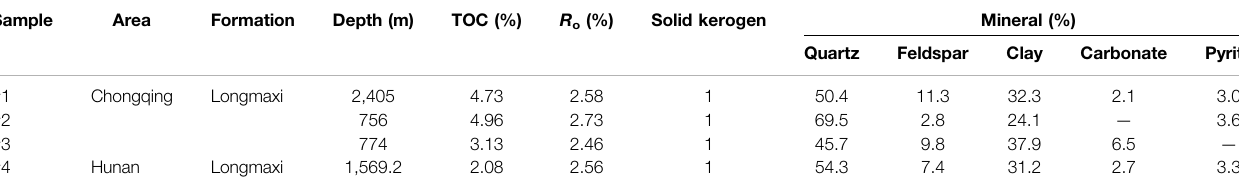
TABLE 2 | The Longmaxi shale samples that are used for FIB-SEM analysis in Figures 7 , 8 and their reservoir characteristics in Chongqing and Hunan.